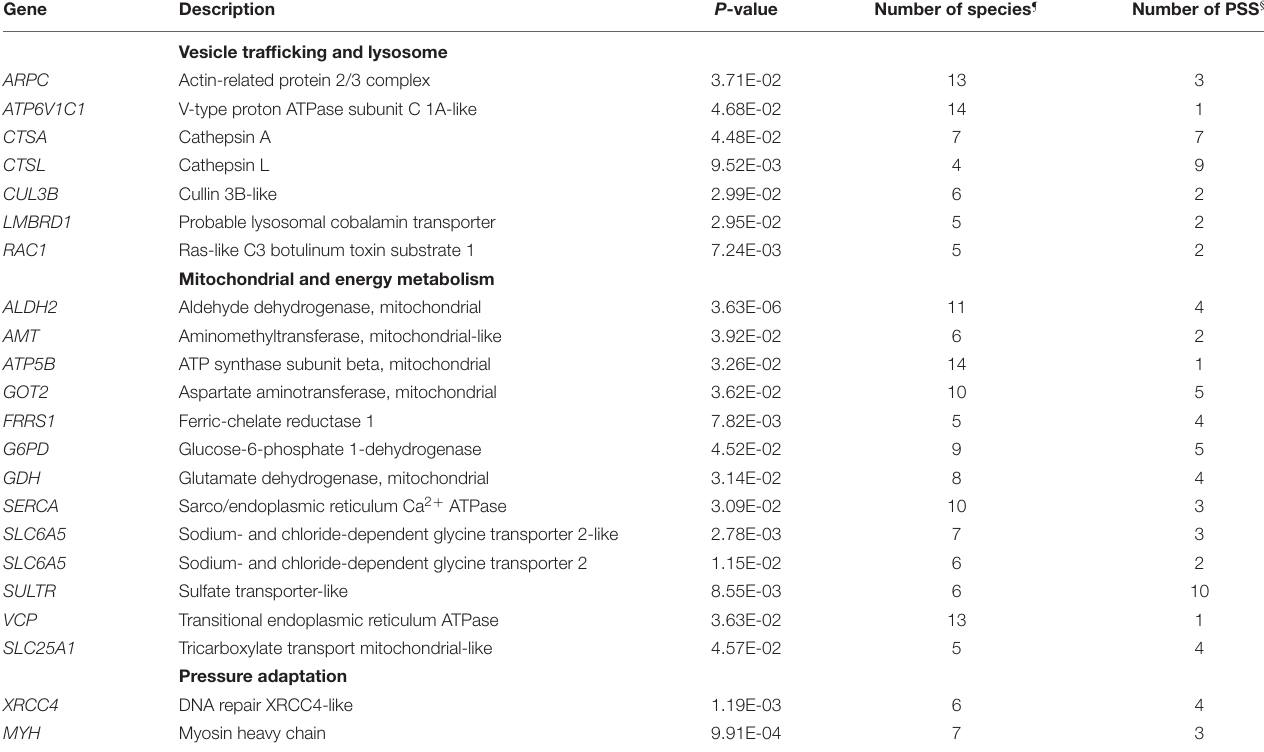
TABLE 1 | Positively selected genes in Phreagena okutanii and Archivesica marissinica . Gene Description P